Question: What style of plot is this figure drawn as?
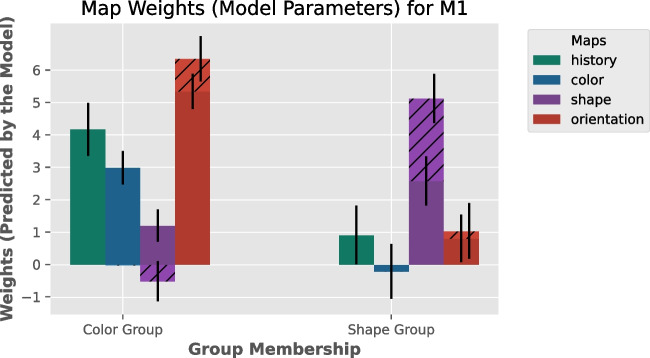
Answer: bar